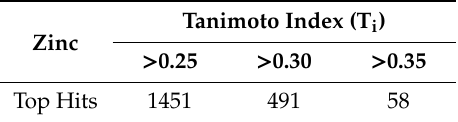
Table 6. Similarity studies of molecules using the Tanimoto